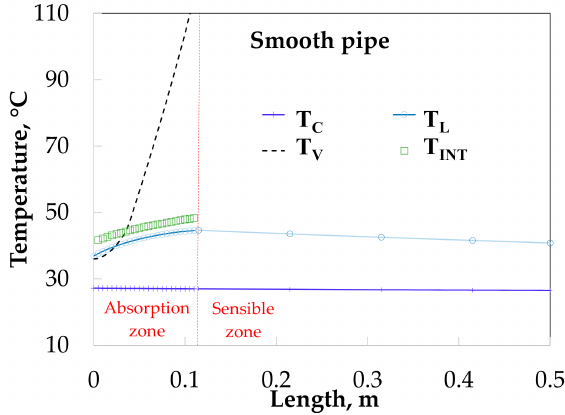
Figure 11. Temperature profiles along the absorber with absorption.